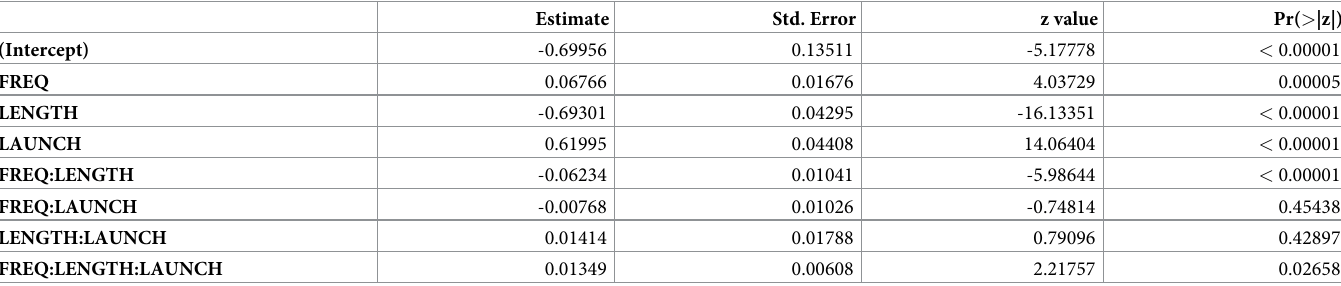
Table 5. Fixed effects of optimal GLMM (Model 2’) for the probability of word